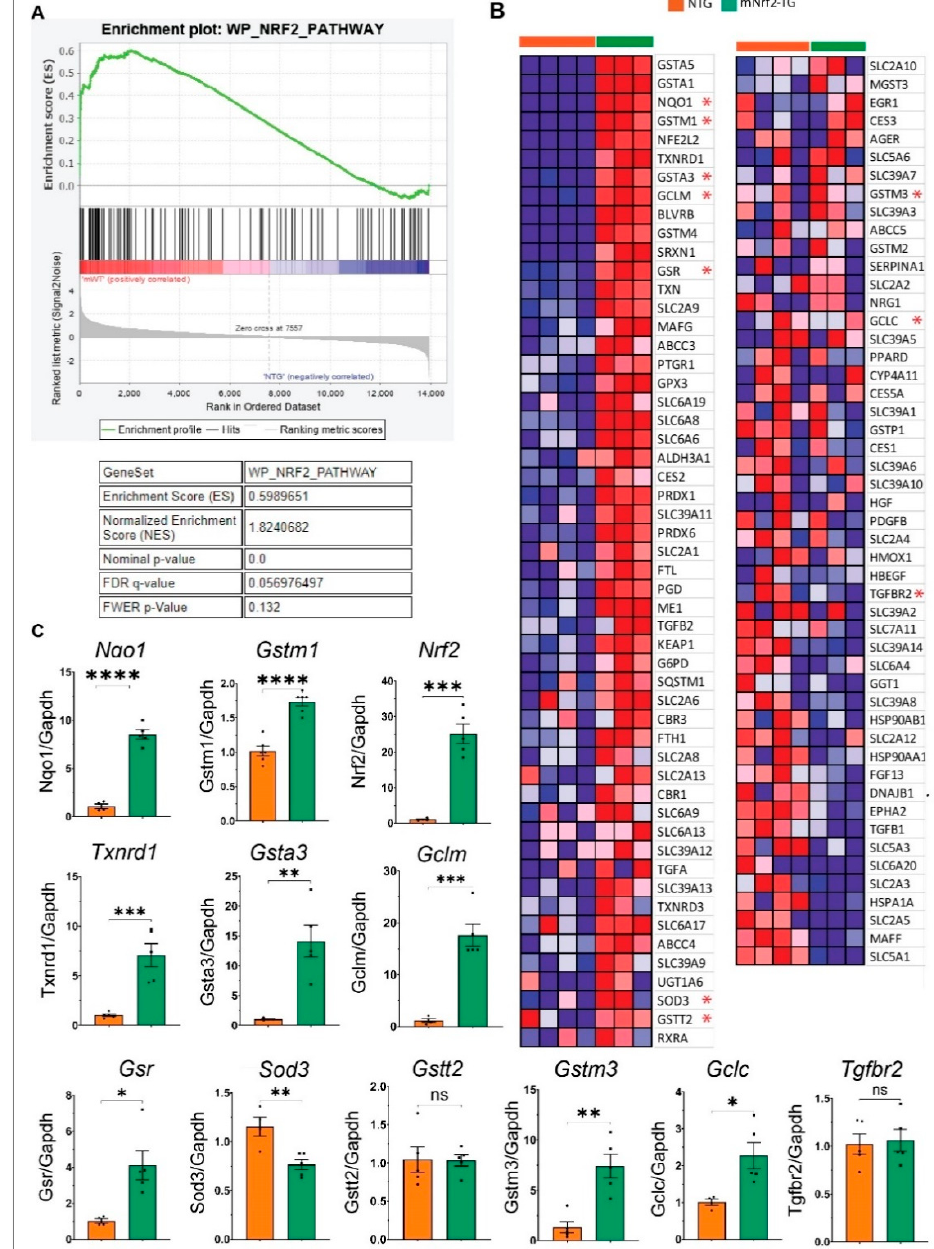
Figure 2. Antioxidant transcriptome in enhanced cardiac Nrf2 signalling. ( A ) GSEA plot of most enriched Nrf2 pathway from Wikipathways. GSEA algorithm calculates an enrichment score for a pathway by walking down the ranked list of genes, increasing a running-sum statistic when a gene is in the gene set and decreasing it when it is not. The magnitude of the increment depends on the correlation of the gene with the phenotype. The ES is the maximum deviation from zero encountered in walking the list. A positive ES indicates gene set enrichment at the top of the ranked list; a negative ES indicates gene set enrichment at the bottom of the ranked list. ( B ) Heatmap illustrating changes in 103 genes enriched in the Nrf2 pathway. ( C ) RT-qPCR validation of gene expression of Gstm1 , Gsta3 , Gstt2 and Gstm3 , Nrf2 , Txnrd1 , Sod3 and Tgfbr2 . All RT-qPCR gene expression were normalized to Gapdh. Error bars represent SEM. * p -value < 0.05, ** p -value < 0.01, *** p -value < 0.001, **** p -value <